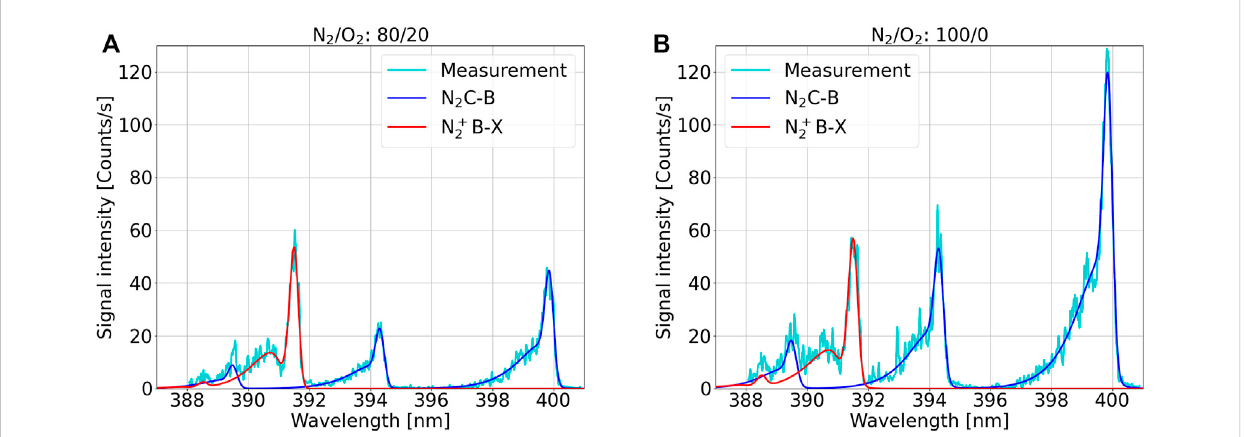
FIGURE 6 Spectral fi tsof (A) syntheticairand (B) purenitrogenat33 mbarand8 kV,500psgatedspectra,takenat7and10 ns,respectively,seeFigure8.The fi t ofFNSandSPSisseparatedtodemonstratepossibleoverlapsofFNS(0 – 0),SPS (2 – 5)andSPS (3 – 6).Itshouldbenoted,thatintensitiesaredividedbythe accumulation time of the ICCD camera to illustrate the intensity/ratio difference between pure nitrogen and synthetic air.